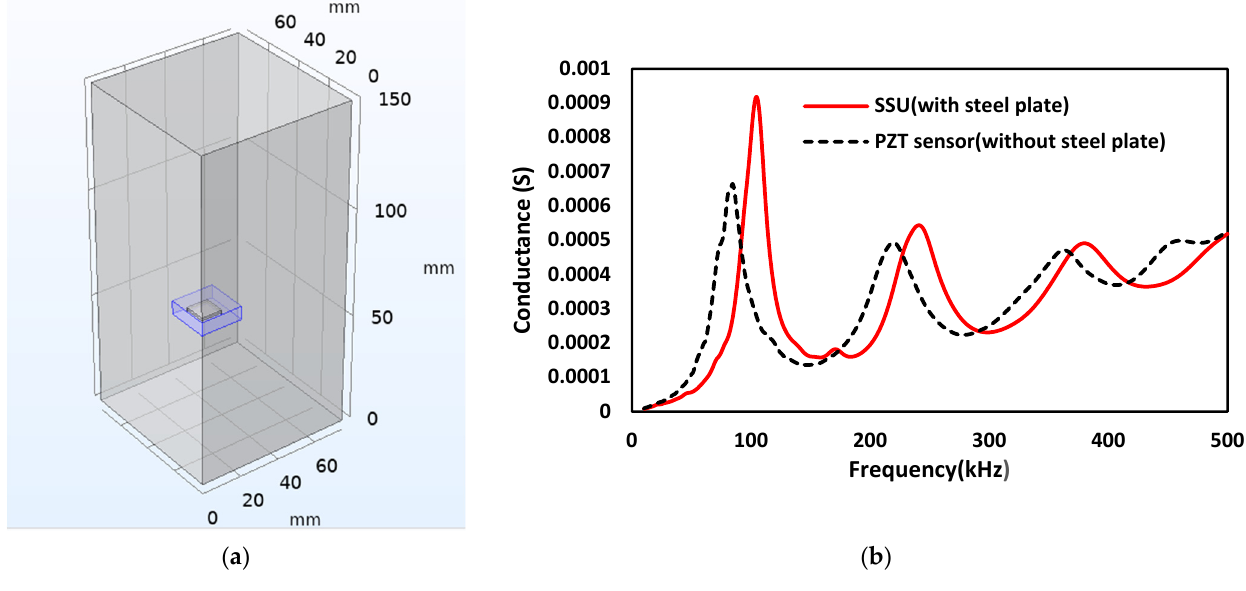
Figure 11. EMI measurement of SSU embedded in concrete: ( a ) One-fourth symmetry model; ( b ) Conductance response obtained.